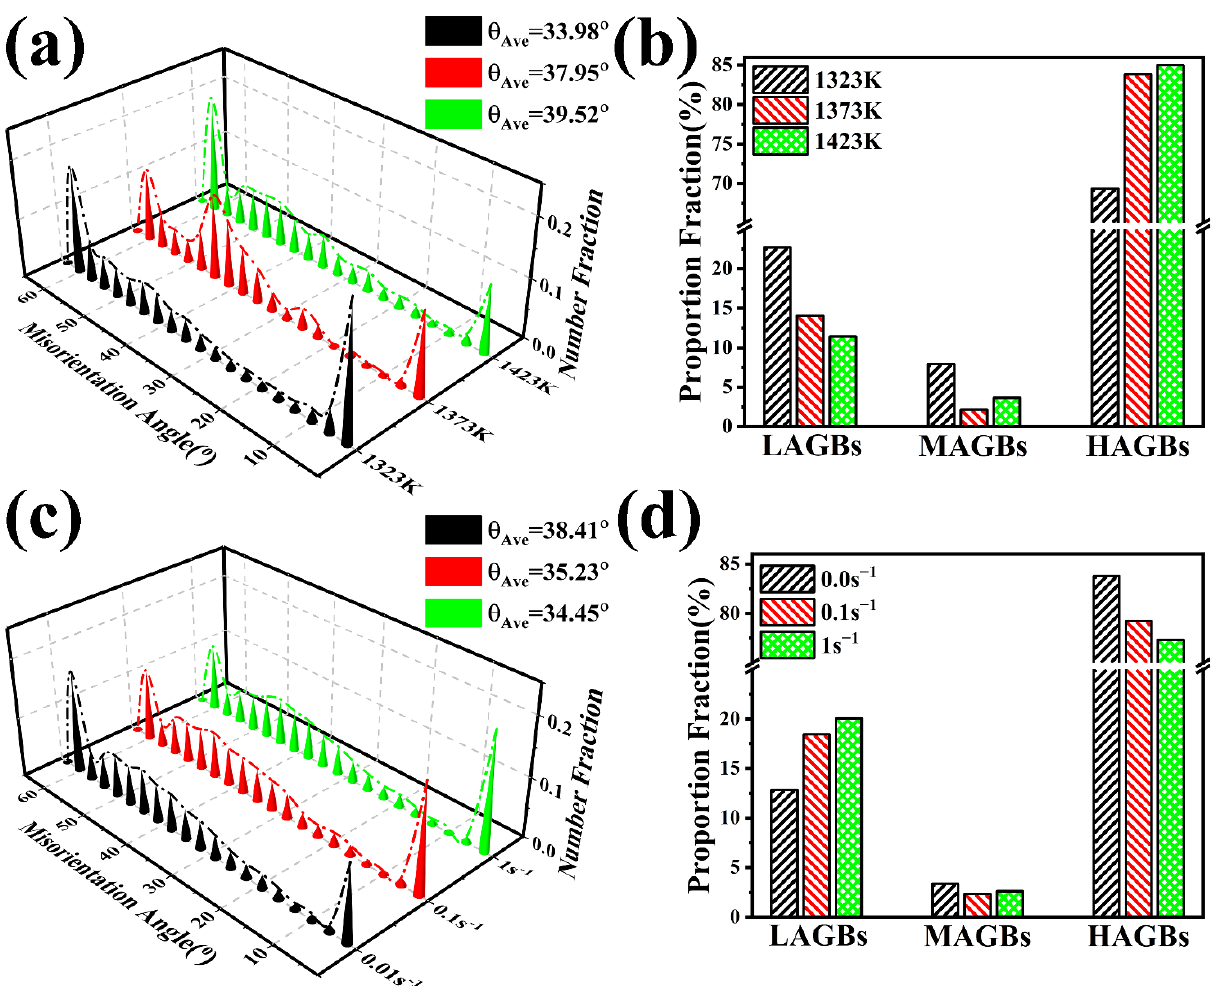
Figure 6. Distributions of misorientation angle of studied superalloy obtained at: ( a ) strain rate of 1 s −1 with different deformation temperatures of 1323, 1373, and 1423 K; ( c ) deformation temperature of 1393 K with different strain rates of 0.01, 0.1, and 1.0 s −1 . ( b , d ) correspond to the fractions of HAGBs, MAGBs, and LAGBs in ( a , c ), separately.